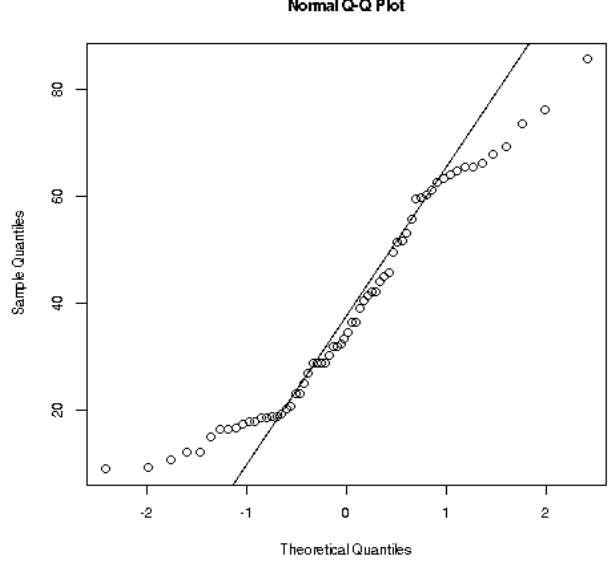
Figure 1. Graphical representation of the data distribution Source: